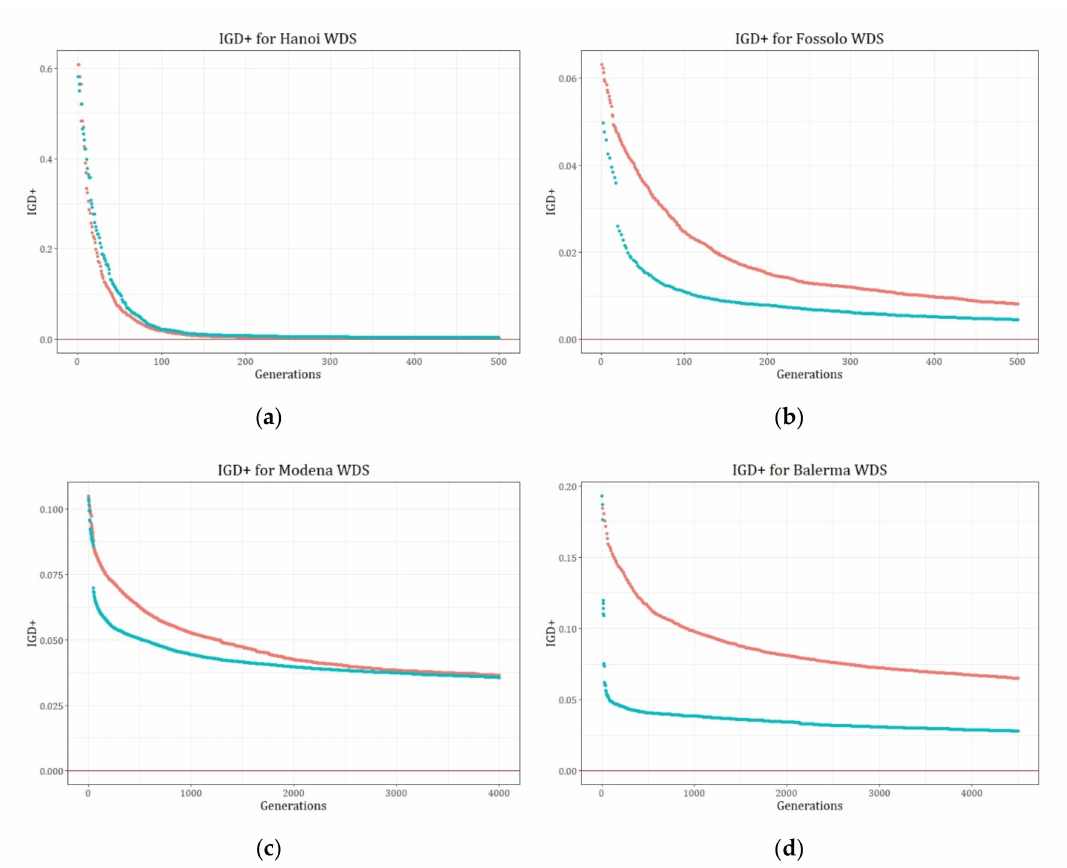
Figure 7. Evolution of the IGD + for assessing the results of the NSGA-II Algorithm (red) and the retrofitted NSGA-II with OPUS (green) in comparison to the inverted generational distance (IGD + ) best-known PF (continuous red line) for tested networks. ( a ) Hanoi; ( b ) Fossolo; ( c ) Modena and ( d )